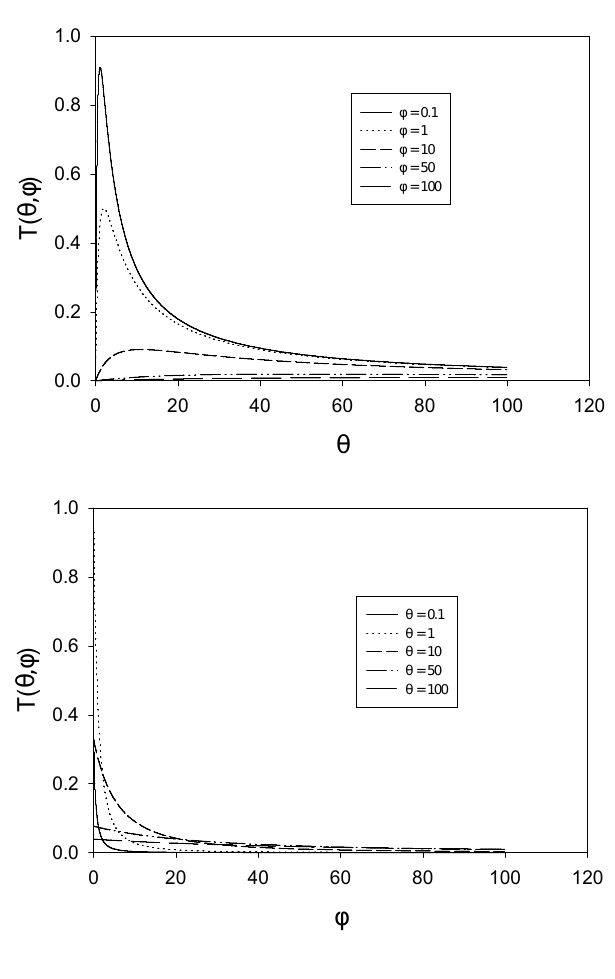
Figure 2. Variation of the T term defined as